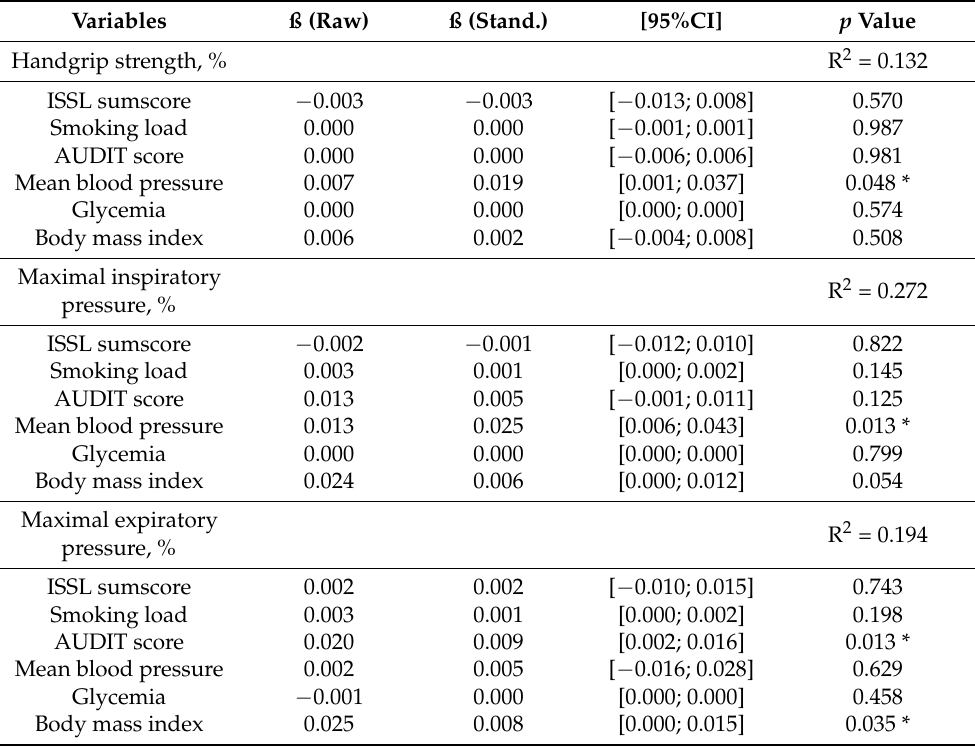
Table 3. Generalized linear models comparing adjusted effect size of cardiovascular disease risk factors (independent variables) on musculoskeletal function (dependent variable) after adjustment by age and